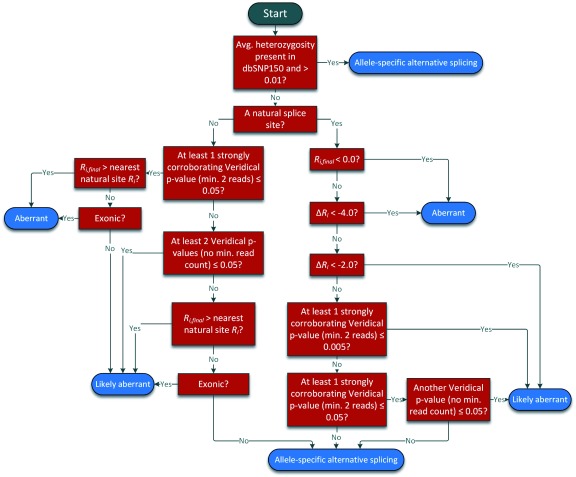
Evidence-Based Case Classification Flowchart.Flowchart depicting steps taken to classify the molecular phenotype of each case. Cryptic site (left) and natural site changes (right) have differing categorization criteria, which involve the combination of information theory-based predictions and Veridical evidence. SNPs common in dbSNP150 (>0.01 average heterozygosity) are immediately considered allele-specific alternative splicing.